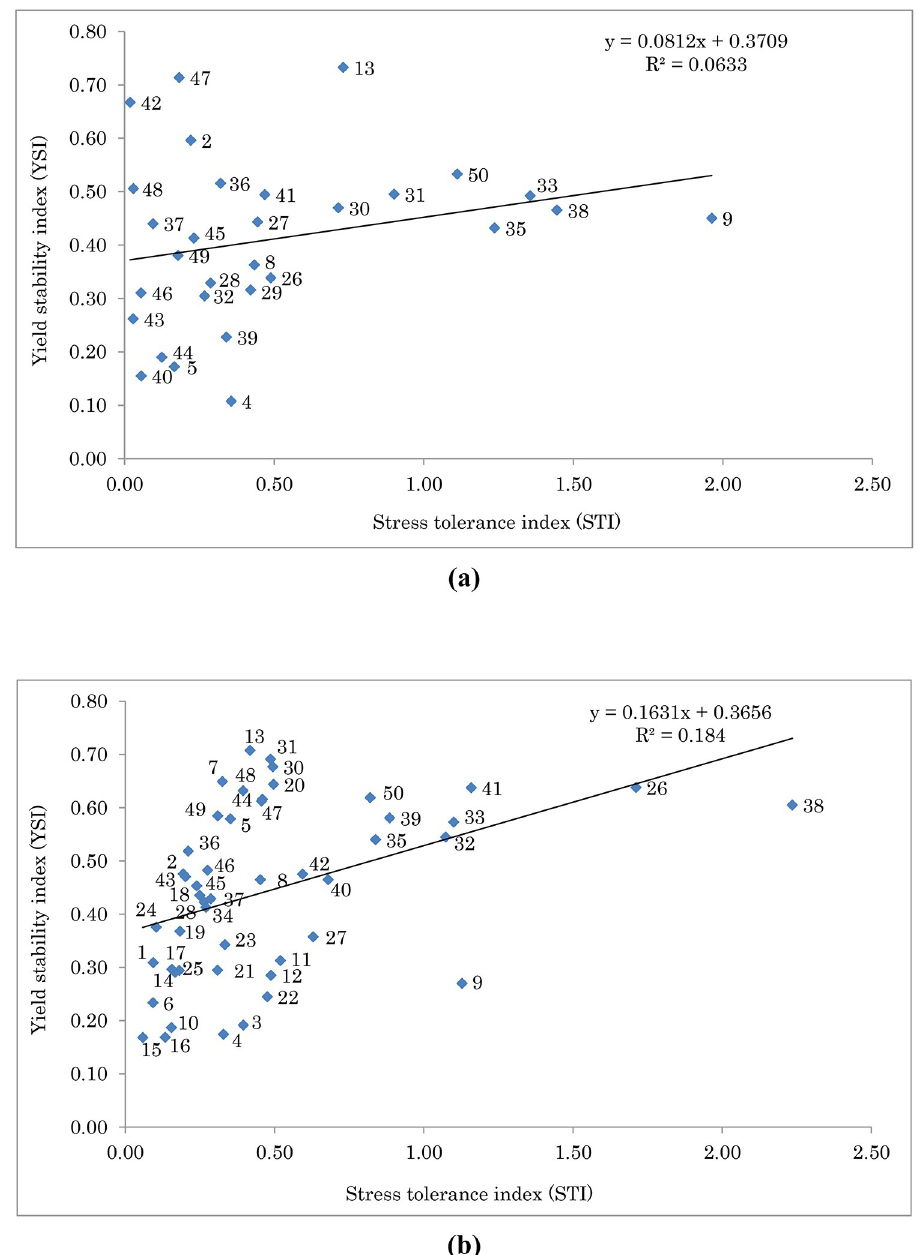
Fig 5. Biplot of stress tolerance index (STI) vs. yield stability index (YSI) for (a) S1 and (b) OP populations of fennel. The F-test indicated that the model is not significant for normal and water deficit conditions. named ‘‘maturity and photosynthetic pigments component”. Moreover, PC2 was positively correlated with SYP, PRO, TChl/CAR, and STI and was considered as “productivity, drought tolerance, and photosynthetic capacity component”. Therefore, selection based on high values of PC1 and PC2 can lead to improvement of productivity, photosynthetic capacity, and drought tolerance of fennel. In this respect, genotypes 13 and 29 were the superior ones (Fig 7B).